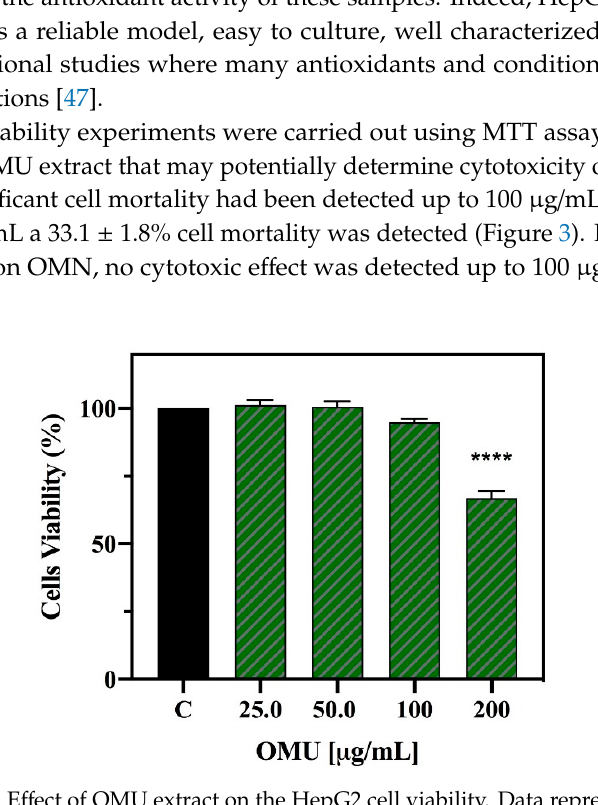
Figure 3. MTT assay. Effect of OMU extract on the HepG2 cell viability. Data represent the mean ± s.d. of three independent experiments performed in triplicate. The statistical significance of C vs OMU 200 μ g/mL was analyzed by t-student test. (****) p < 0.0001, C: control cells.